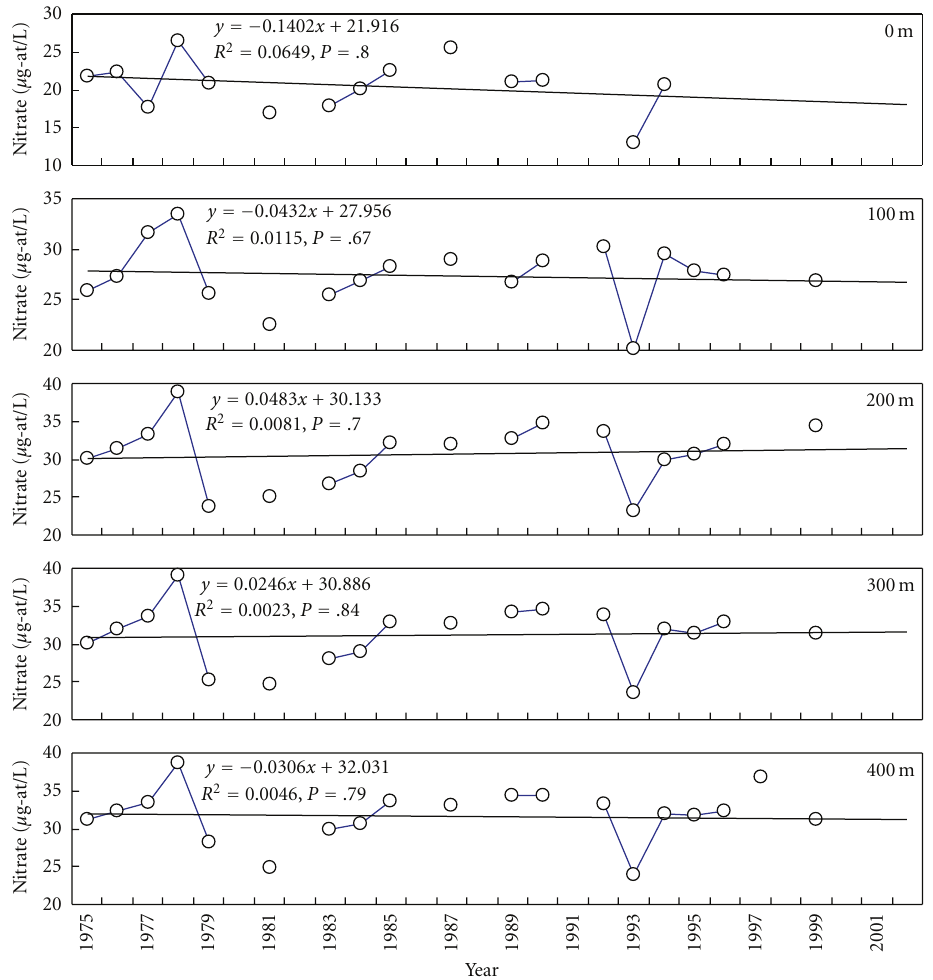
Figure 9: Long-term time series of the mean nitrate concentrations at the surface, 100 m, 200 m, 300 m, and 400m during austral summer (January–March) between 1975 and 2002. Solid lines represent linear